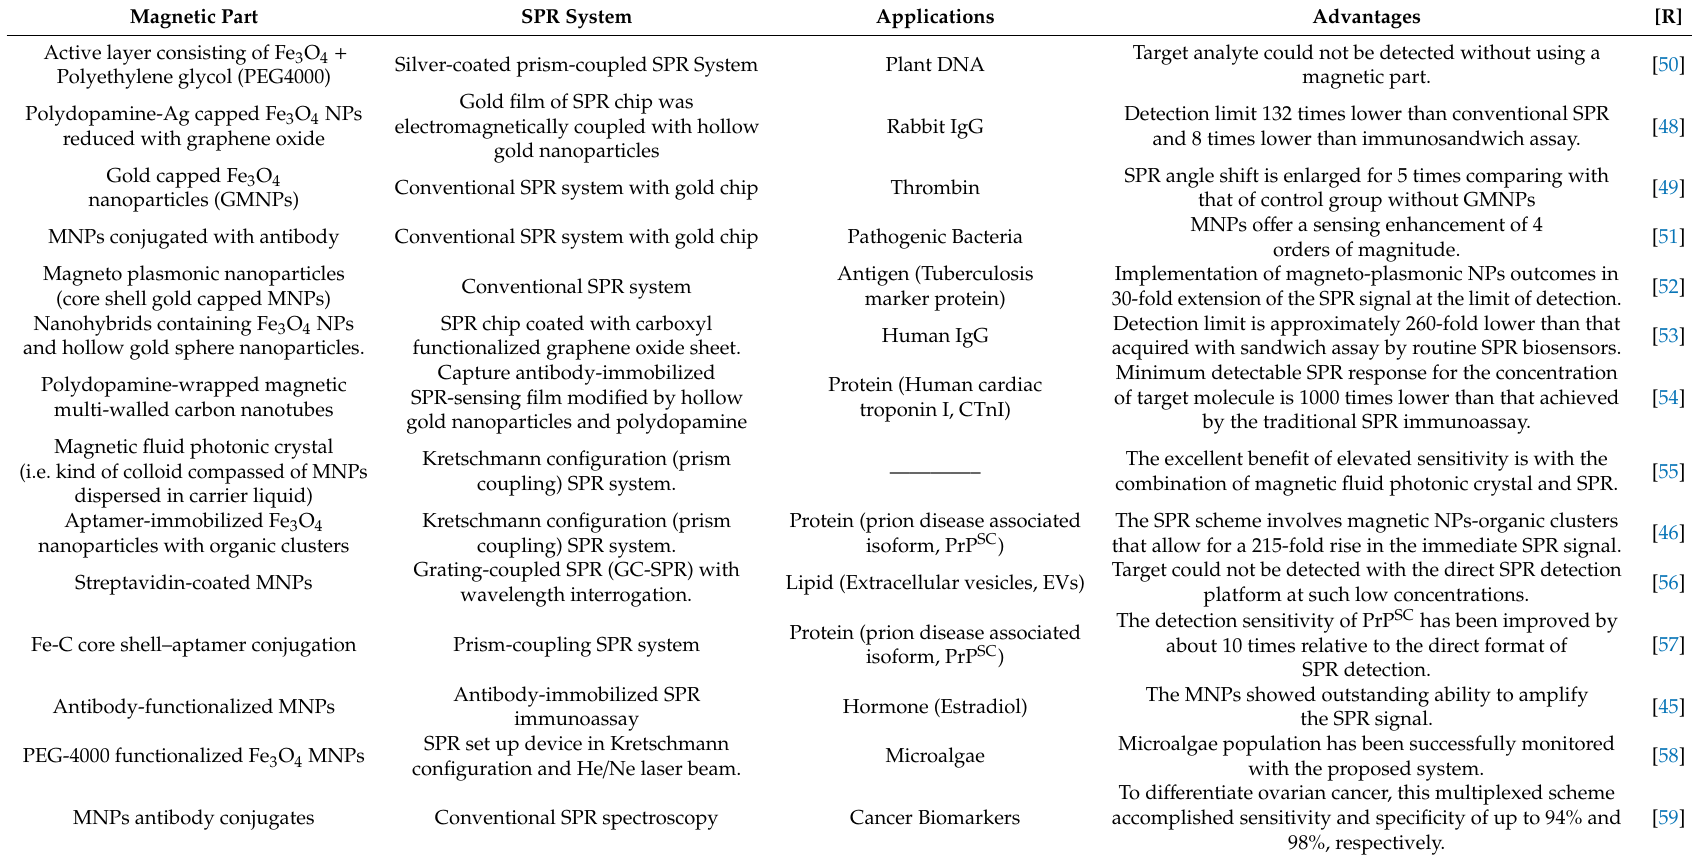
Table 1. Examples of the application of MNPs in SPR